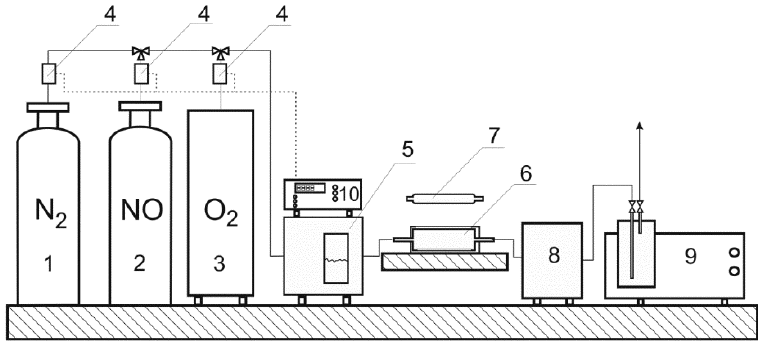
Figure 6. Experimental set-up: 1—N 2 gas cylinder, 2—NO in N 2 gas cylinder C = 0.5%—AIR PRODUCTS, 3—oxygen generator PSA—AirSep Onyx, 4—mass flowmeters—Brooks Instruments SLA5850, 5—humidifying unit—LAT UNG-1, 6—photocatalytic reactor, 7—450 W xenon lamp— Osram, 8—drying unit—LAT OS-3, 9—FTIR spectrometer—Jasco FTIR 4200 equipped with the gas cuvette, 10—control panel for mass flow meters—Brooks Instruments.